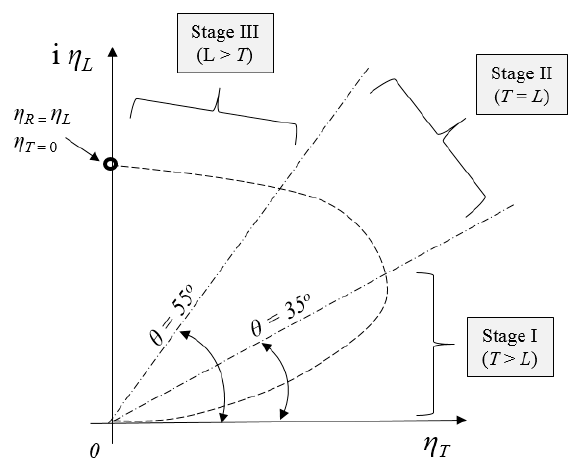
Figure 9. Two instantaneous conditions. Point B corresponds to hovering or vertically ascending flight.